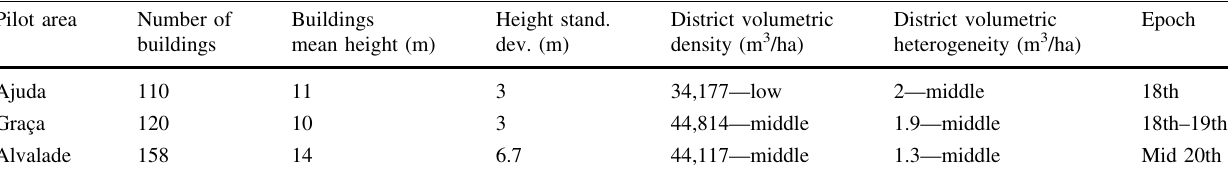
Table 9 Urban morphologic characteristics of the pilot areas